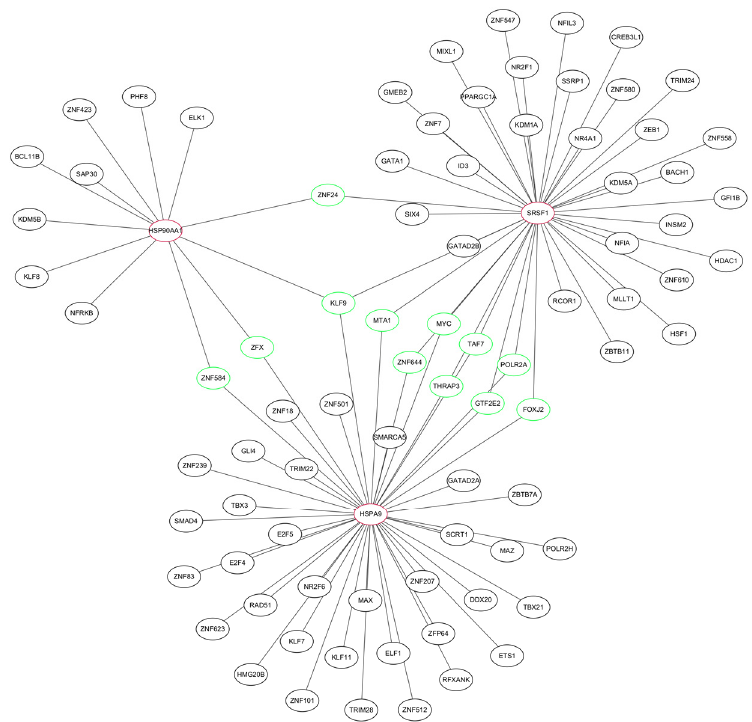
Figure 6. TF–mRNA regulatory network of the three hub genes. Red indicates hub genes, green indicates transcription factors (TFs) associated with at least two of the hub genes.